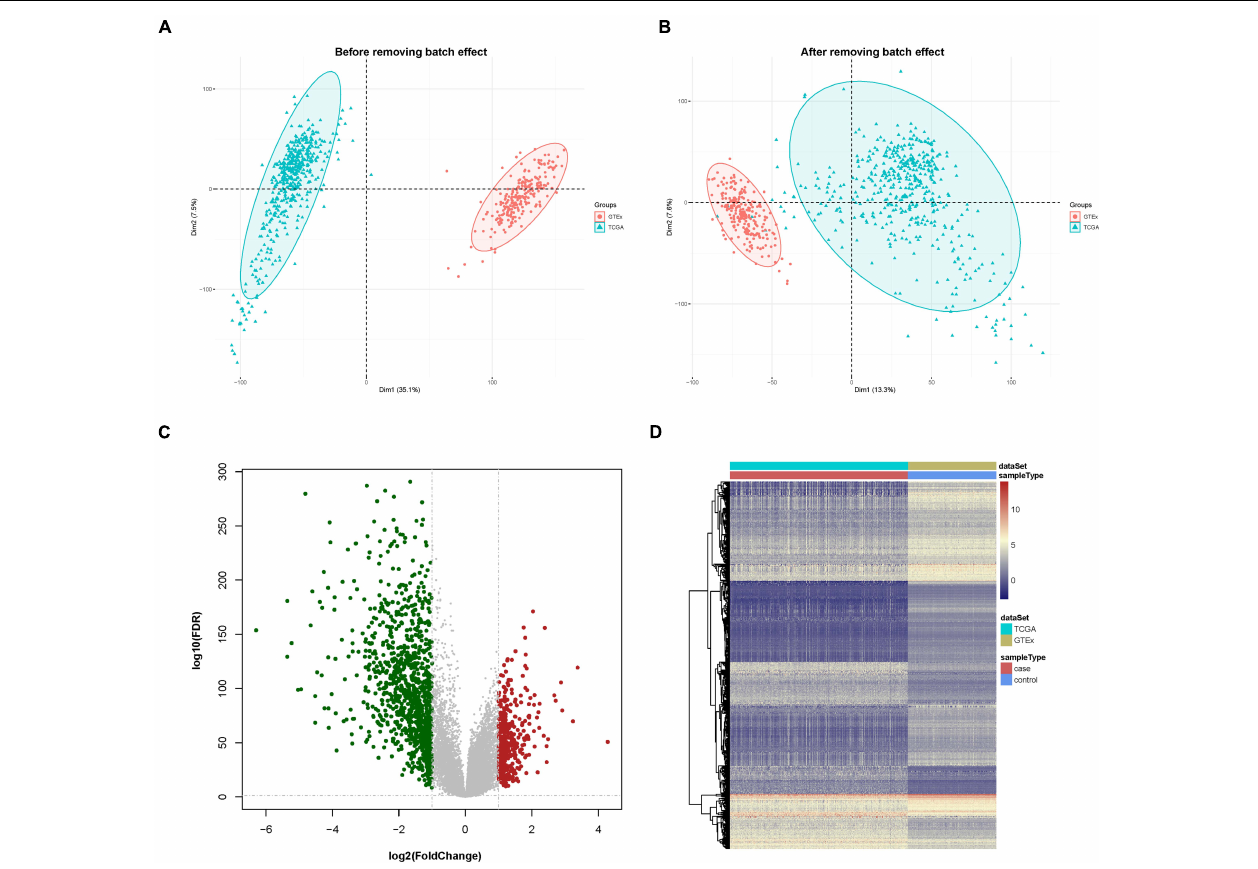
FIGURE 1 | Data preprocessing and identification of differentially expressed genes (DEGs). (A) Principal component analysis (PCA) analysis before the removal of batch effect. (B) PCA analysis after the removal of batch effect. (C) DEG volcano plot; red dots designate upregulated genes, green dots designate downregulated genes, and gray dots designate no difference genes. (D) Hierarchical clustering heat map of expression values sorted according to sample (rows) and gene (columns), where the color changed from red to yellow and green suggesting gene expression changed from high to